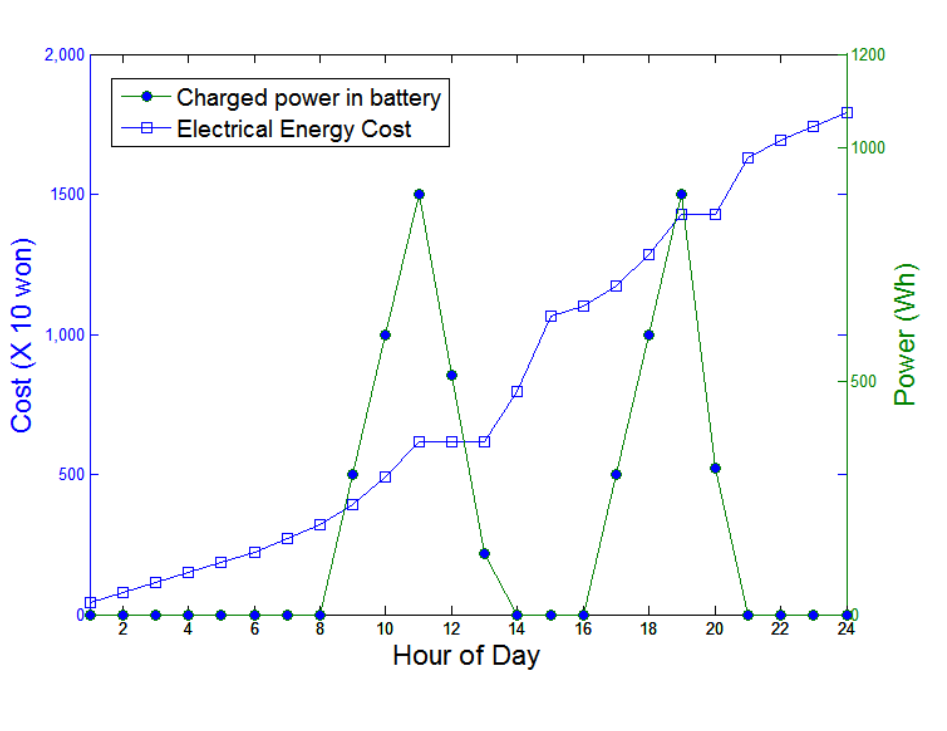
Figure 15. Use of PV power, SOC of the battery and electricity cost under Scenario 2.